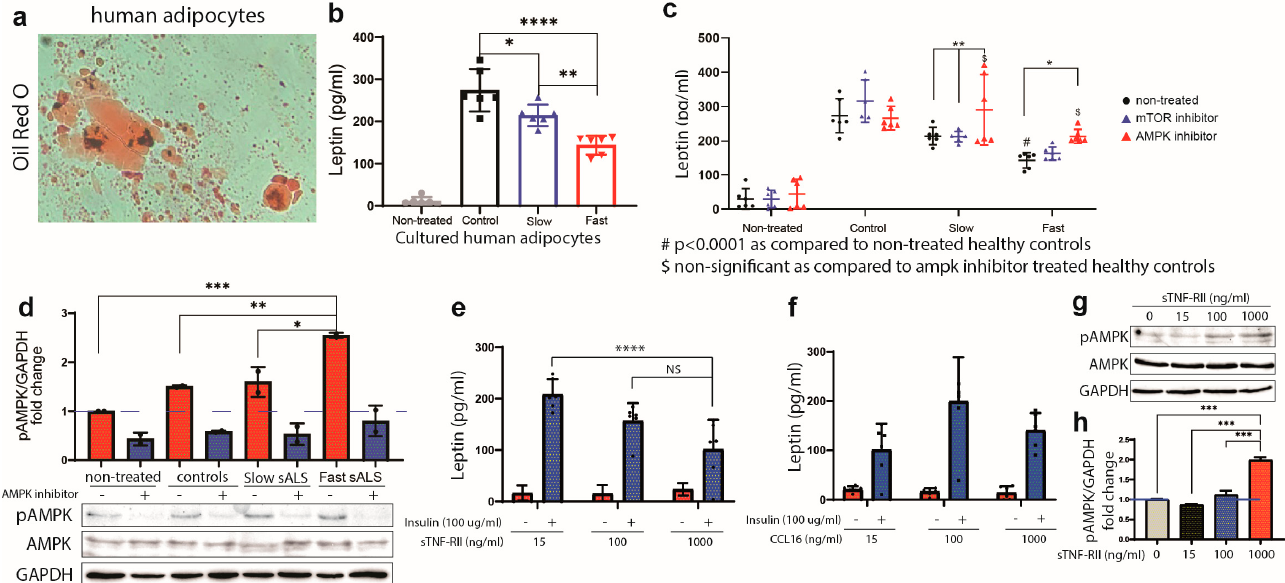
Figure 6. Exposure to plasma from sALS reduces leptin production in human adipocytes. ( a ) Oil red O coloration demonstrating lipid droplet accumulation (red) in mature adipocytes. ( b ) Human